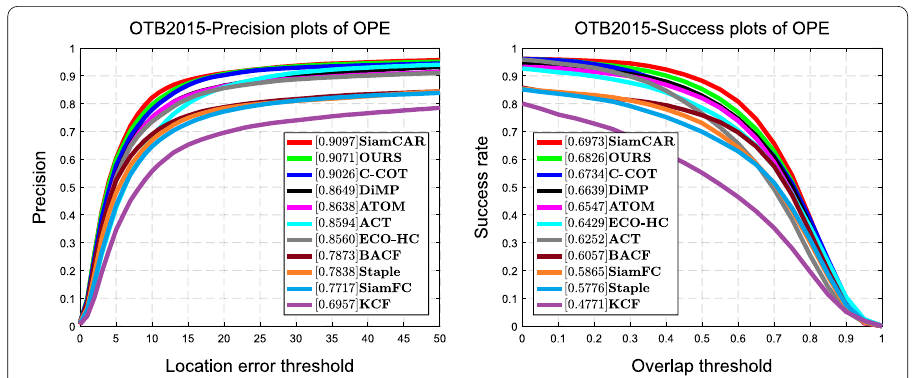
Fig. 5 Performance evaluation results of different algorithms on OTB2015